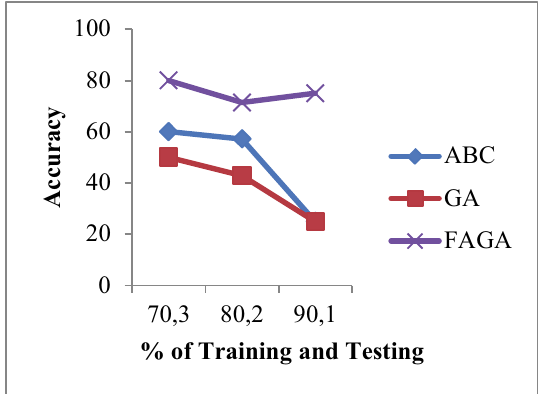
Fig.10. Accuracy using Lung Cancer